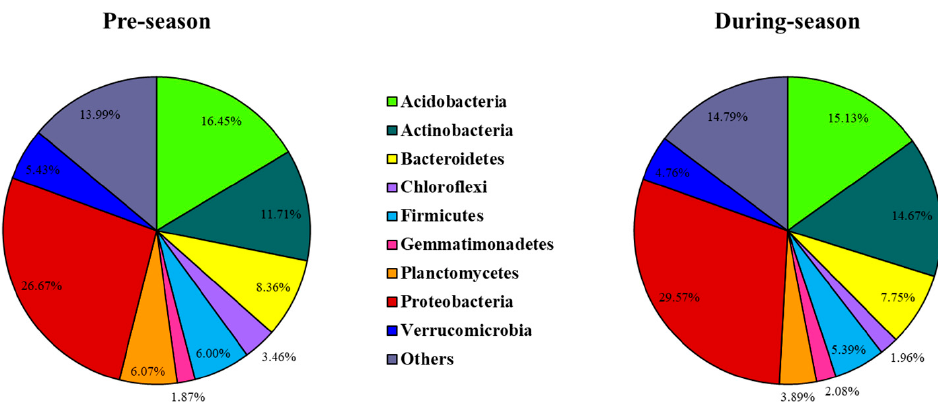
Figure 1. Relative percentages of the phylum level abundances in soil microbiome before ( left ) and after ( right ) the application of animal manure product.